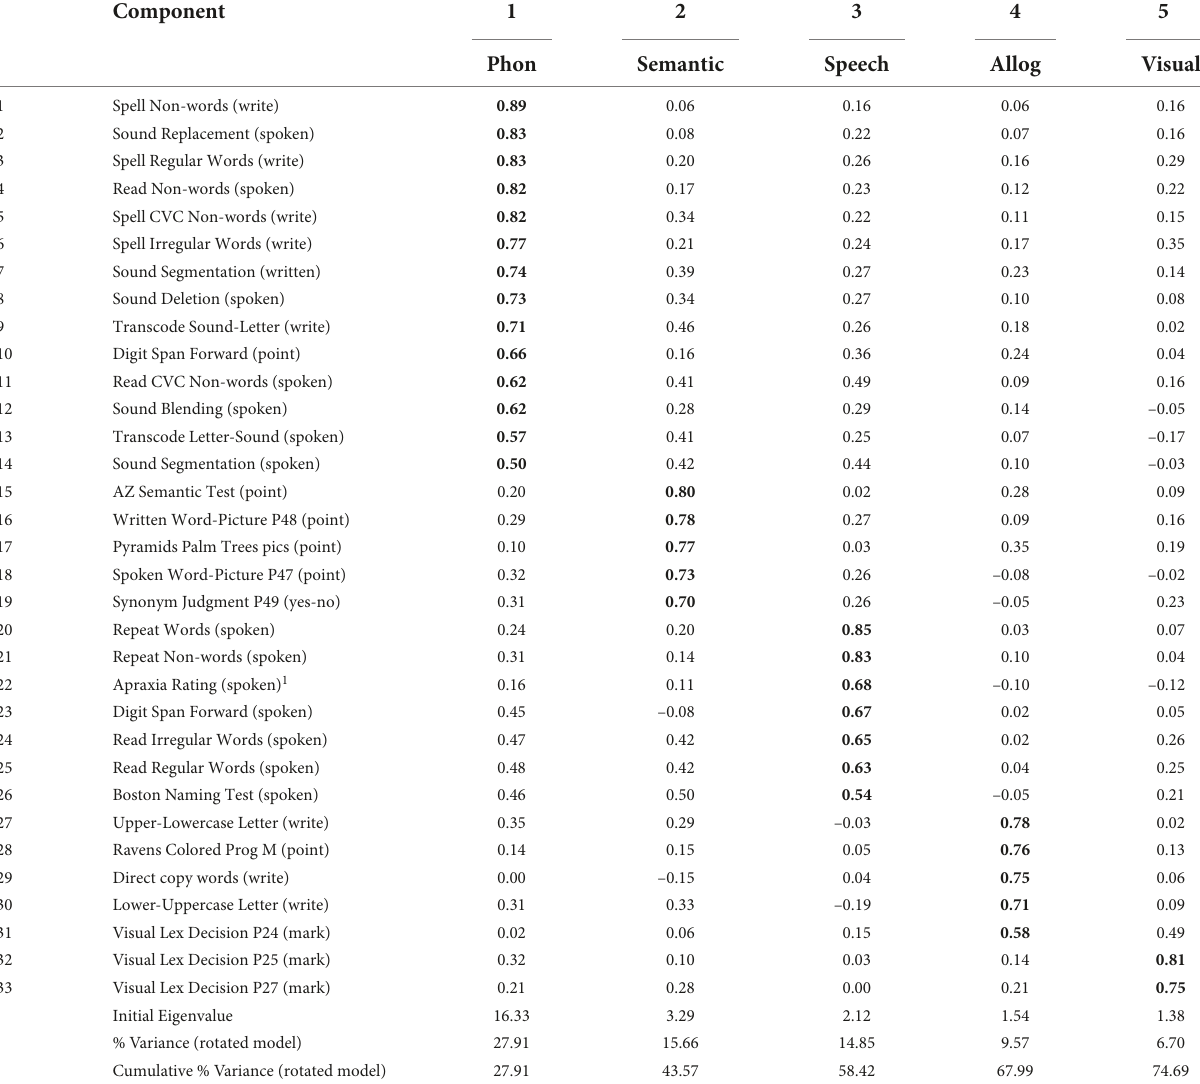
TABLE 4 Results from omnibus principal components analysis implemented using 33 test scores from 85 individuals with language impairment.